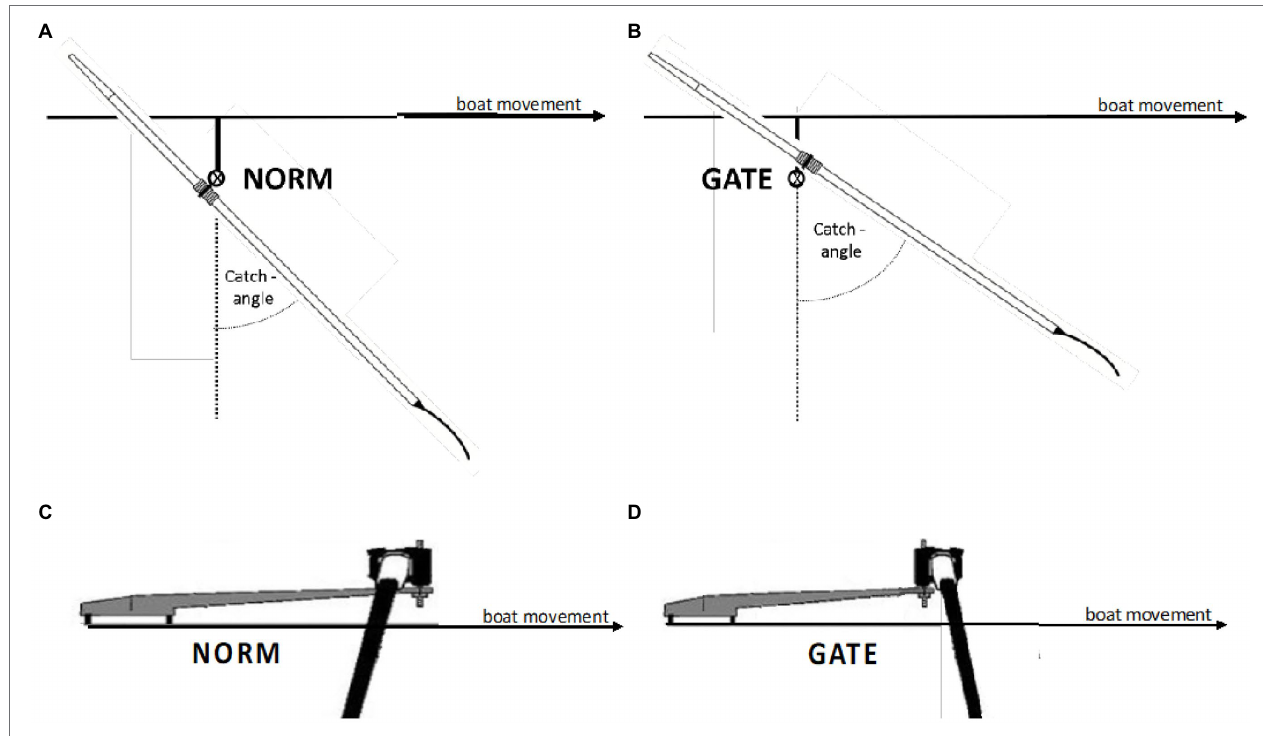
FIGURE 1 | Schematic representation of the standard setup ( A,C ; NORM) and the modified version ( B,D ;